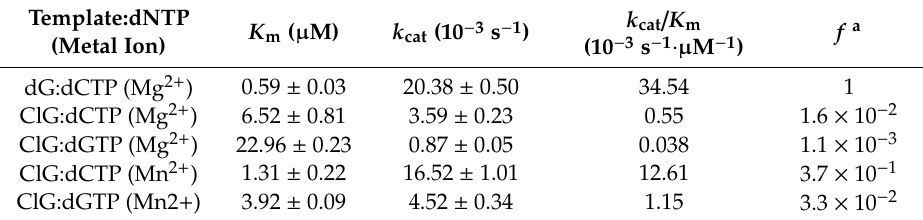
Table 1. Kinetic parameters of dNTPs insertion opposite the ClG